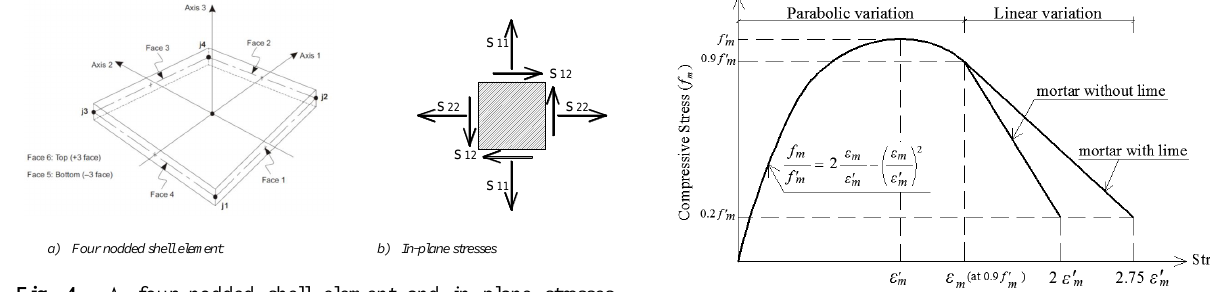
Figure 5. Masonry idealized stress-strain curve for compression (Kausnik et al., 2007) Fig. 5. Masonry idealised stress–strain curve for compression (Kaushik et al.,